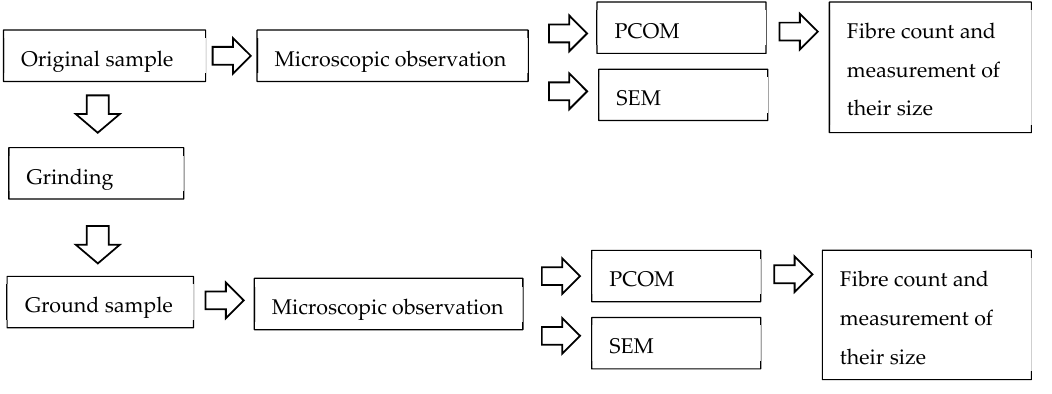
Figure 3. Analysis procedure flowsheet.